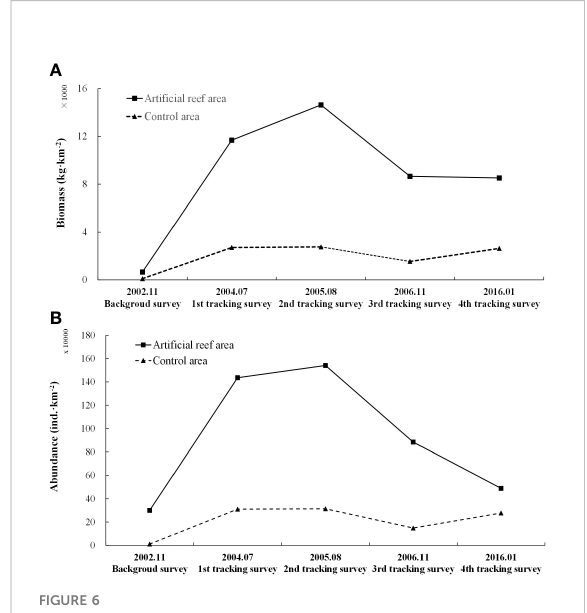
FIGURE 6 Changes in nekton community biomass (A) and abundance (B) in the AR and CA habitats surveyed during each trawl net sampling period.